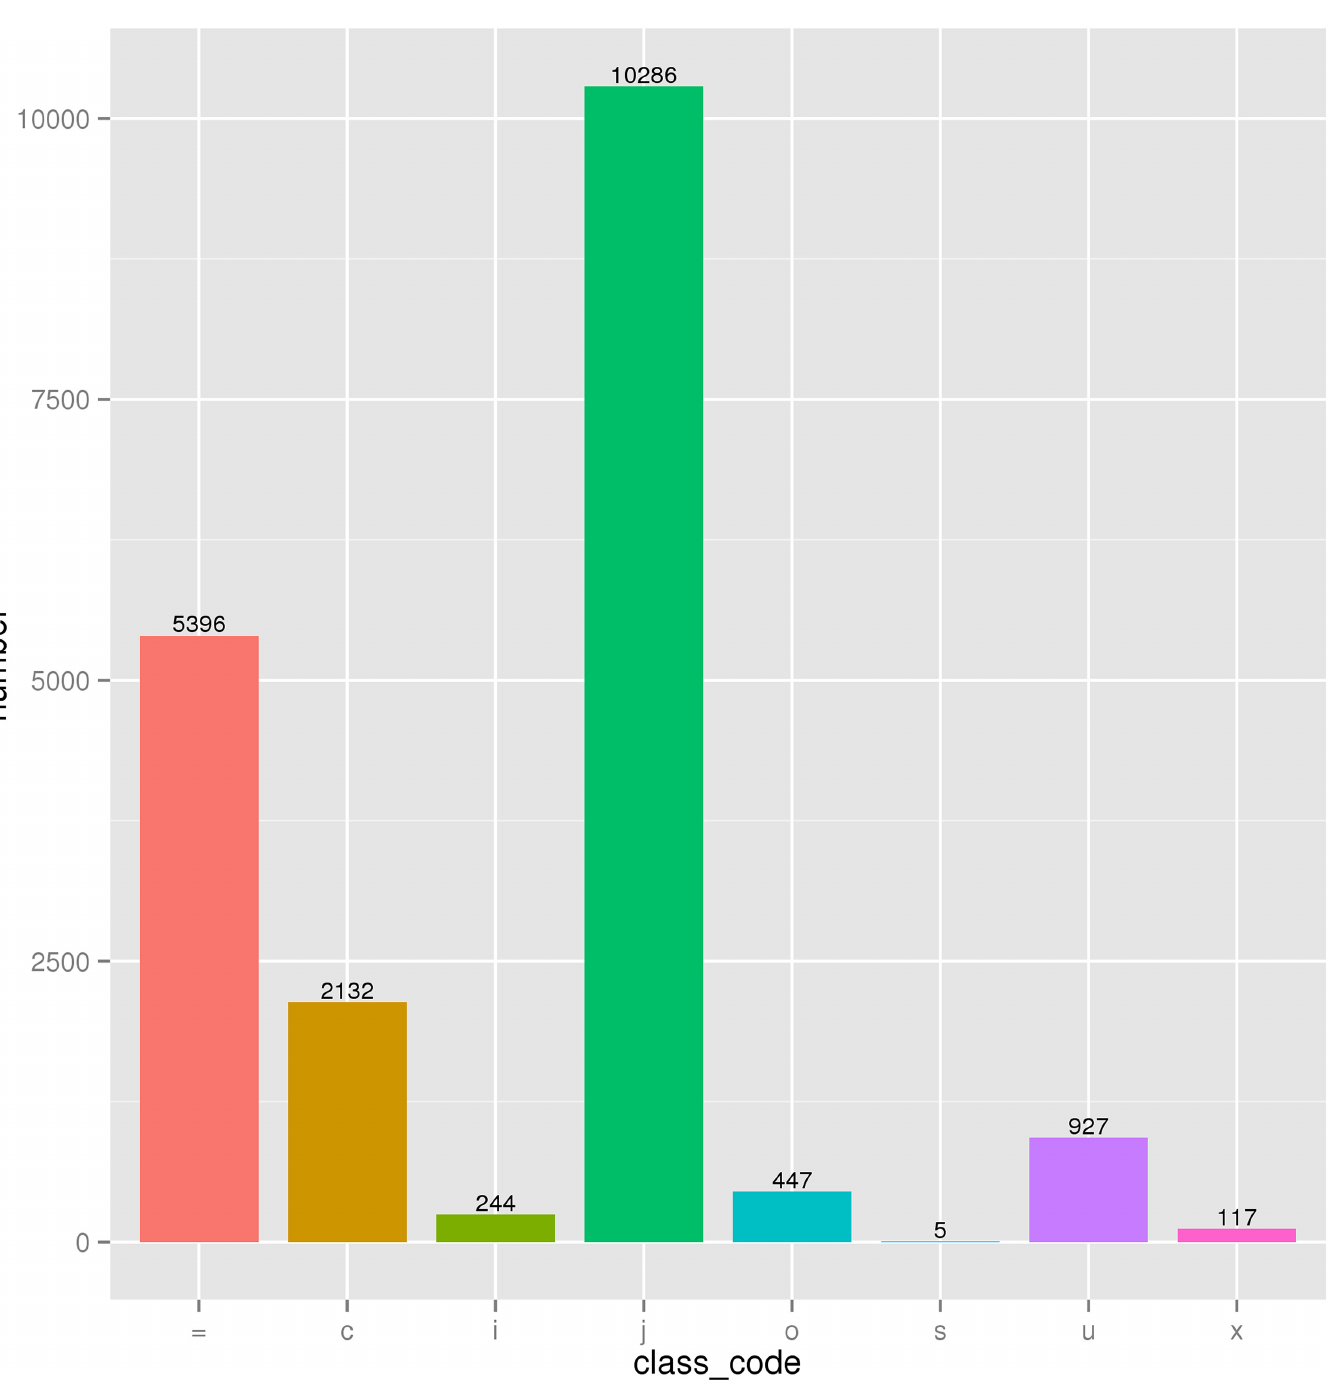
PLOS ONE | DOI:10.1371/journal.pone.0156890 June 8,